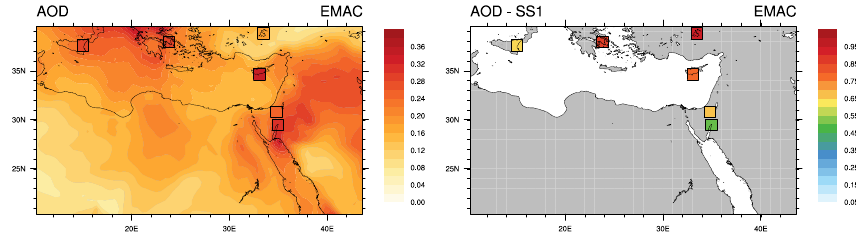
Figure 5. EMAC (T255L31) model results of AOD (550nm) for September 2011 (left) and skill score (right). The six AERONET stations of Fig. 4 are included (squares).